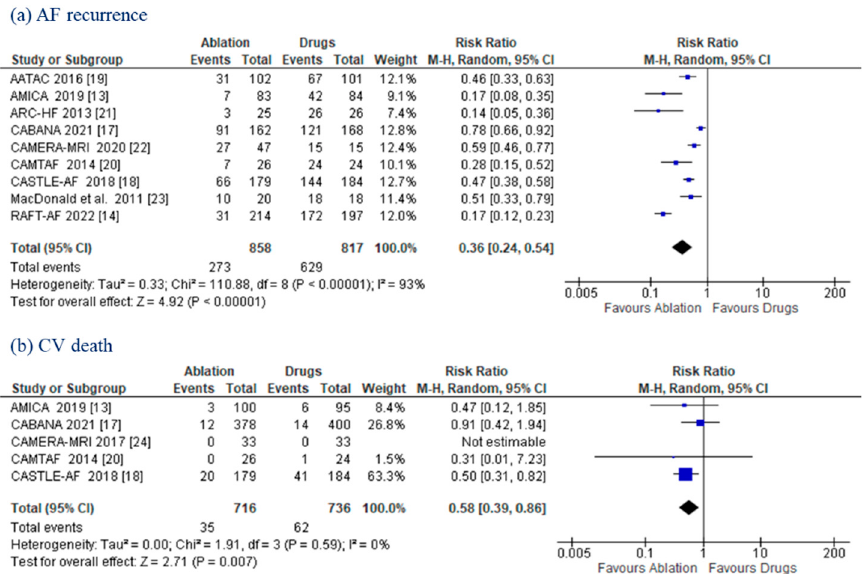
Figure 3. AF Recurrence and CV Death. Forest plots displaying risk ratio in AF recurrence ( a ) and cardiovascular death ( b ) between the ablation and drug groups. AF: atrial fibrillation; CI: confidence interval; CV: cardiovascular; LVEF: left ventricular ejection fraction.